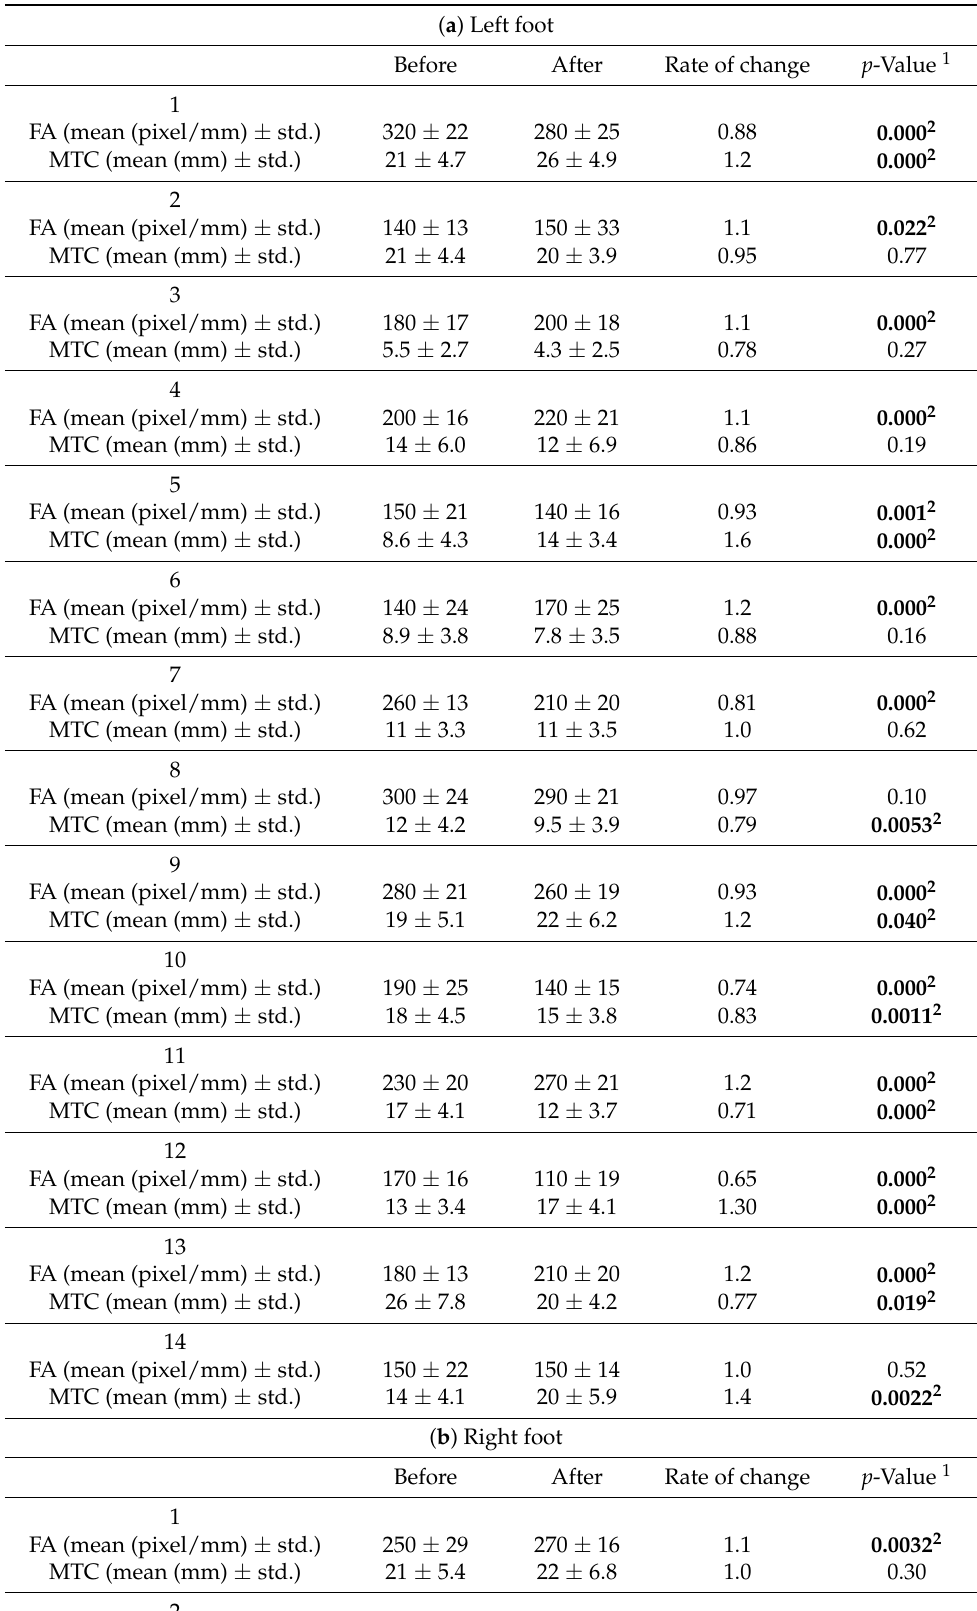
Table 2. Mean FA and MTC of the individual participant and changes in them owing to fatigue. ( a ) Left